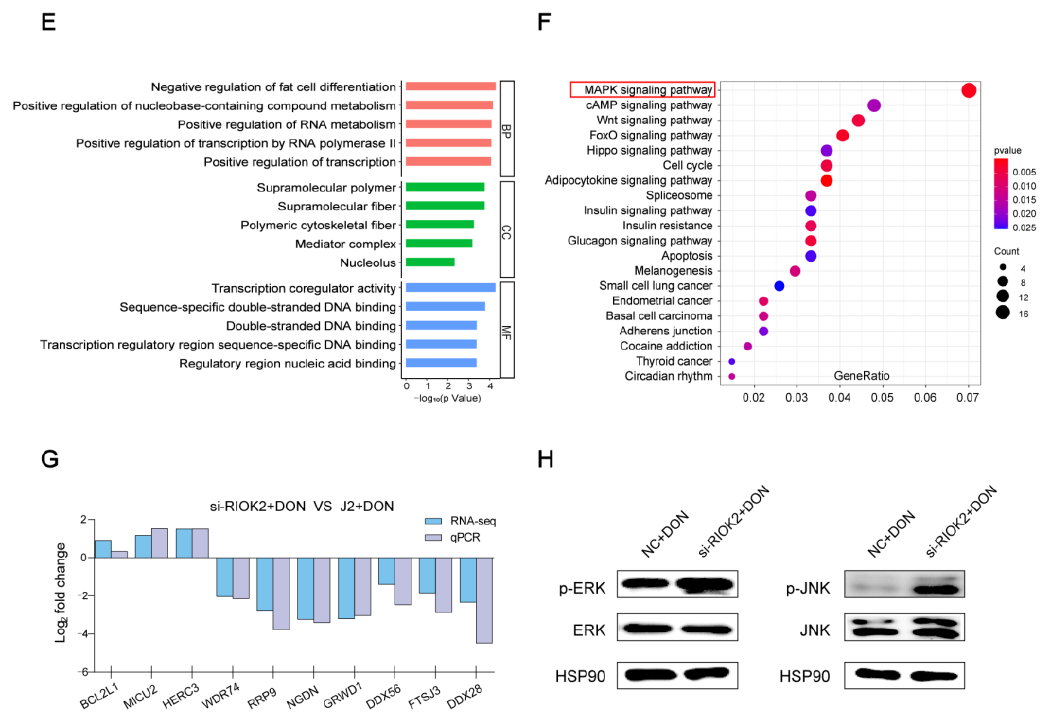
Figure 4. WGCNA showing the mechanism of the downstream regulation of the RIOK2 gene. ( A ) WGCNA cluster dendrogram and module assignment. Colors in horizontal bars indicate modules, and branches refer to highly connected gene clusters. ( B ) Heatmap of the correlation between the module eigengenes and different treatment groups. Each cell contains the correlation coefficient and p -value. ( C ) Overlapping differentially expressed genes and WGCNA blue module hub genes uncover key hub DEGs in DON-induced cytotoxicity regulation. ( D ) Cluster analysis graph of differential gene samples between different groups. ( E ) GO enrichment analysis of 803 hub genes. ( F ) KEGG pathway analysis of 803 hub genes. The significance of enrichment gradually increases from blue to red, and the size of the dots indicates the number of genes contained in the corresponding pathway. ( G ) qPCR validation of differentially expressed genes. ( H ) Inhibition of RIOK2 promotes the activation of the MAPK signaling pathway in DON-induced